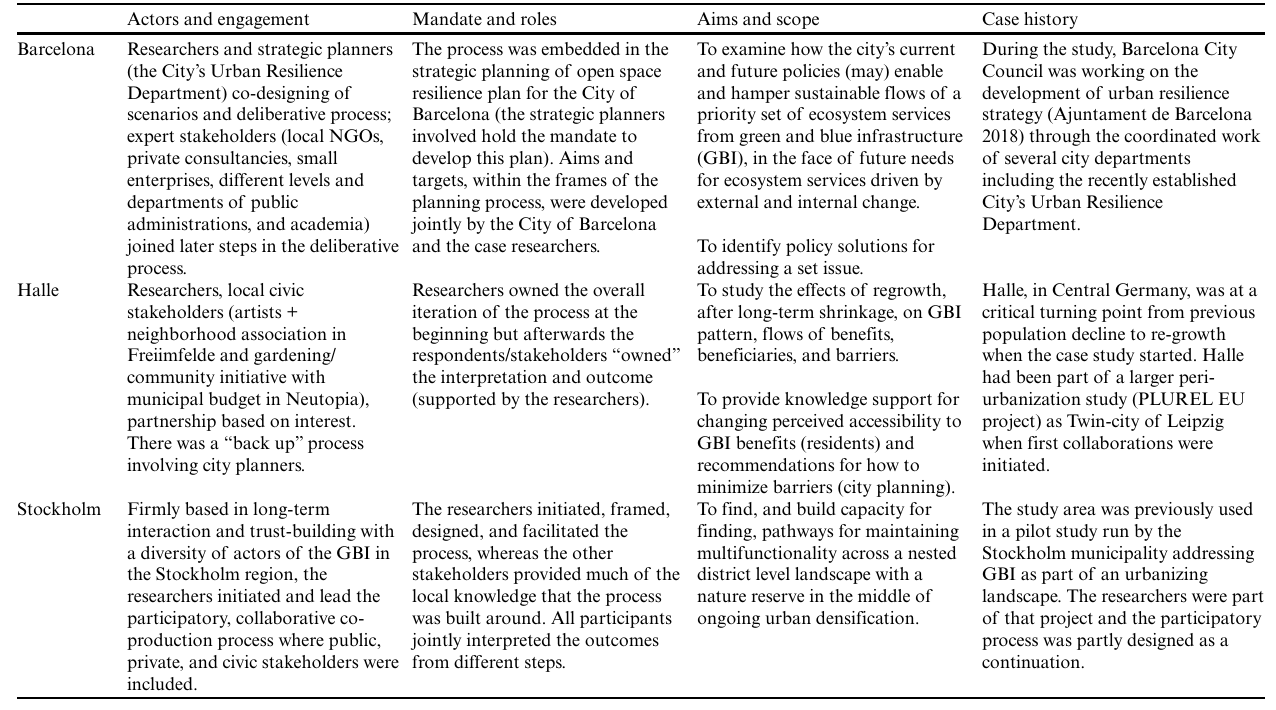
Table 1 . Three modes of transdisciplinary deliberation processes Actors and